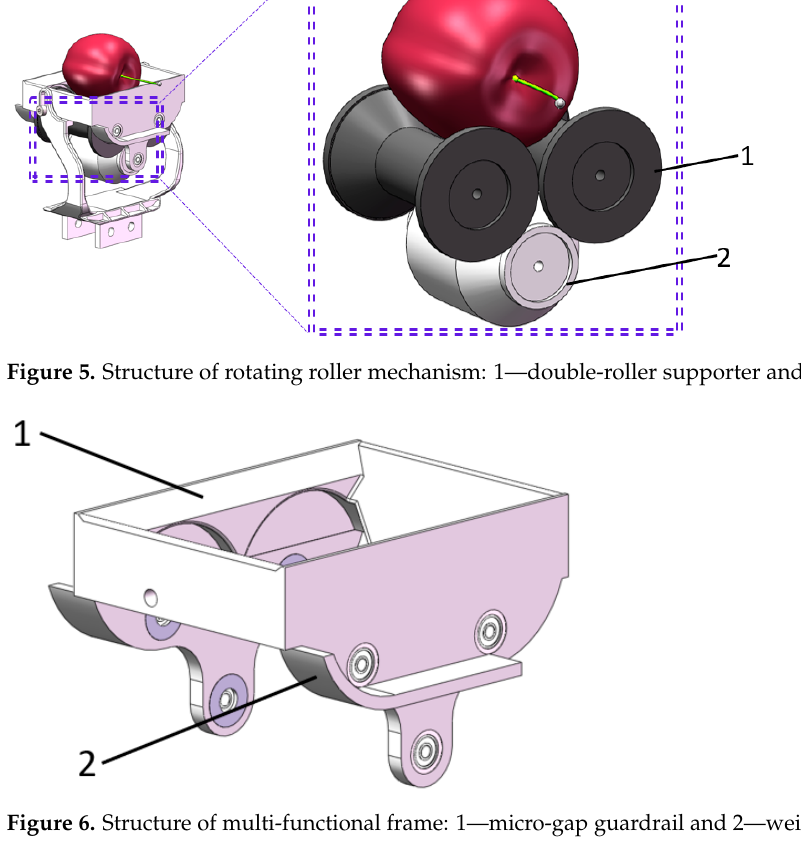
Figure 5. Structure of rotating roller mechanism: 1—double-roller supporter and 2—driven roller.